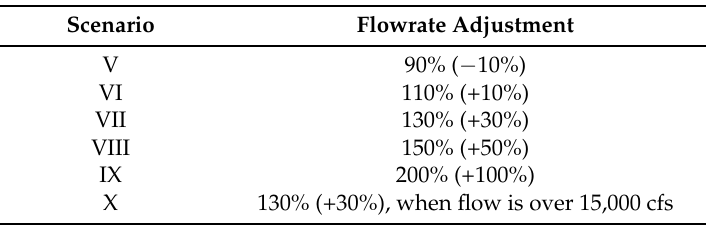
Table 2. Flow adjustments for additional simulation scenarios.